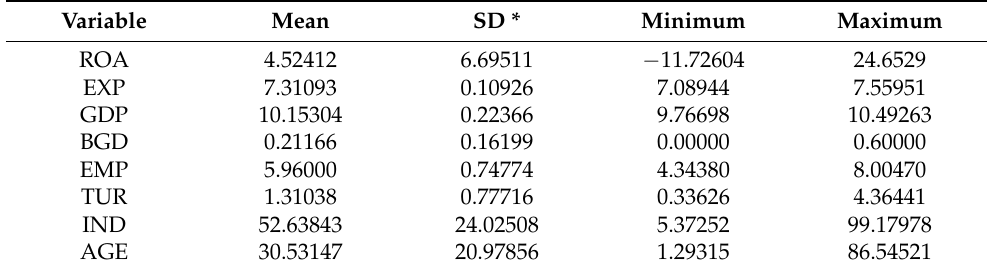
Table 2. Descriptive statistics of the continuous